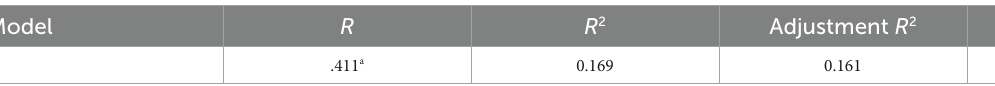
TABLE 11 Model analysis.